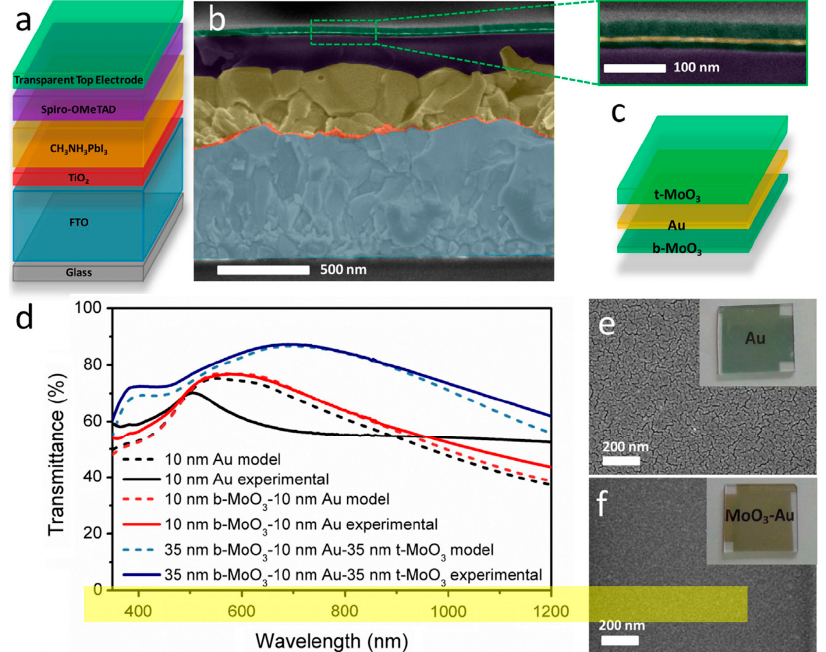
Figure 8. ( a ) Schematic representation of the PSC architecture (not to scale). ( b ) SEM image of a complete device in cross-section. ( c ) Detailed illustration of the multilayer top electrode and its structural schematic. ( d ) Experimental data (solid lines) and simulation results (shaded dashed lines) depict the transmittance of Au(black), b-MoO 3 /Au (red), and b-MoO 3 /Au/t-MoO 3 (blue). ( e ) Au film SEM image. ( f ) b-MoO 3 /Au film SEM image. The insets show photos of the two samples [117].